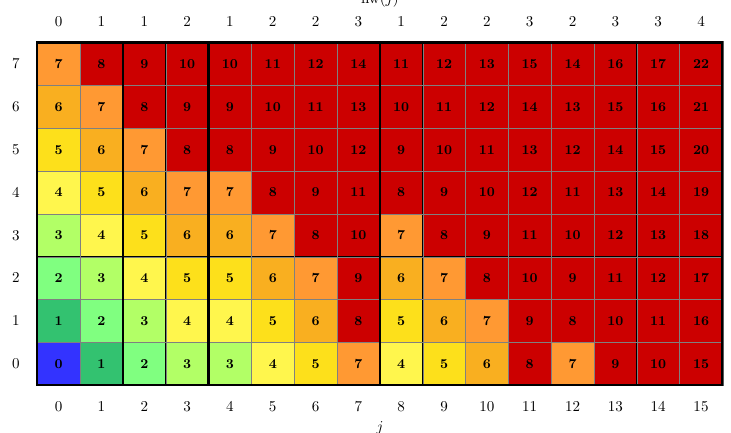
Figure 5. Smallest possible candidate indices m l , j for L = 8 and P = 4 with candidates j [ 0, L and list index l 1 ] calculated by the PO-based method. ∈ −